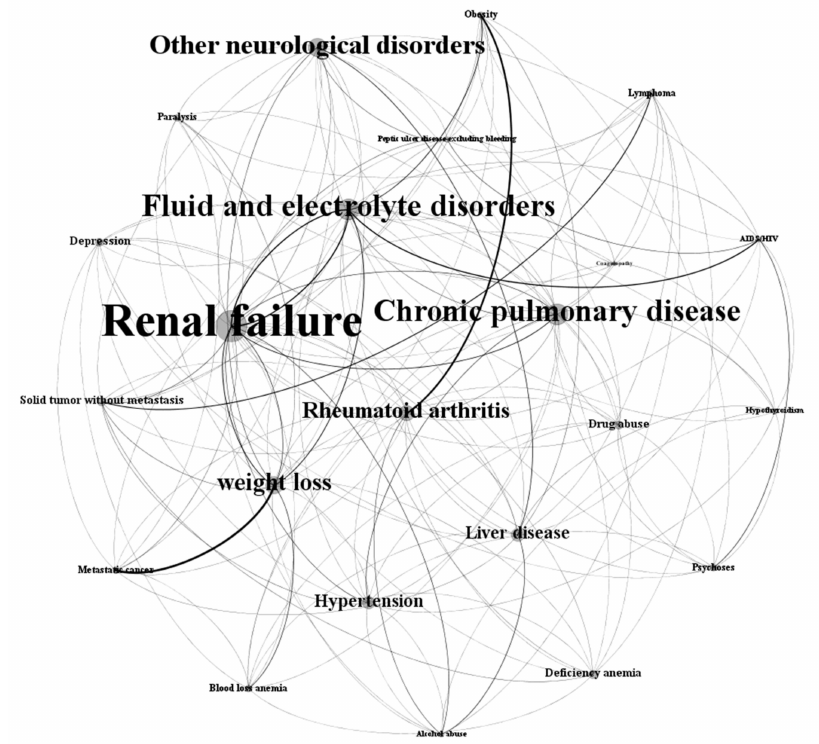
Figure 5. Final disease network of T2DM patients progressing towards CVD. The node size and labels are proportional to the prevalence of the corresponding comorbidity. The thickness of an edge between two comorbidities is proportional to its